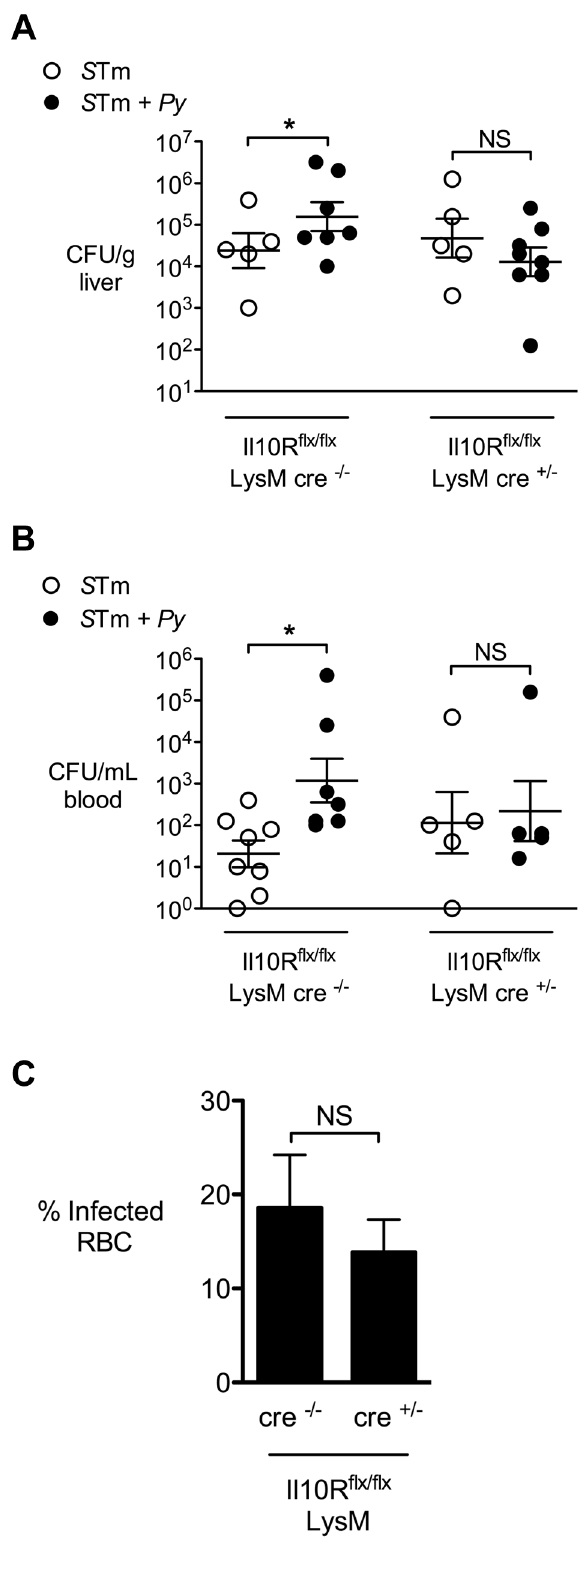
Figure 5. Malaria parasite-induced IL-10 acts on myeloid cells. Mice conditionally deficient for IL-10 receptor (Il10R) on myeloid cells ( Il10R f/f LysM-cre ) or Cre-negative littermate controls were infected with S. Typhimurium or co-infected with S. Typhimurium and P. yoelii . Bacterial colonization was assessed 2 days after IP inoculation with